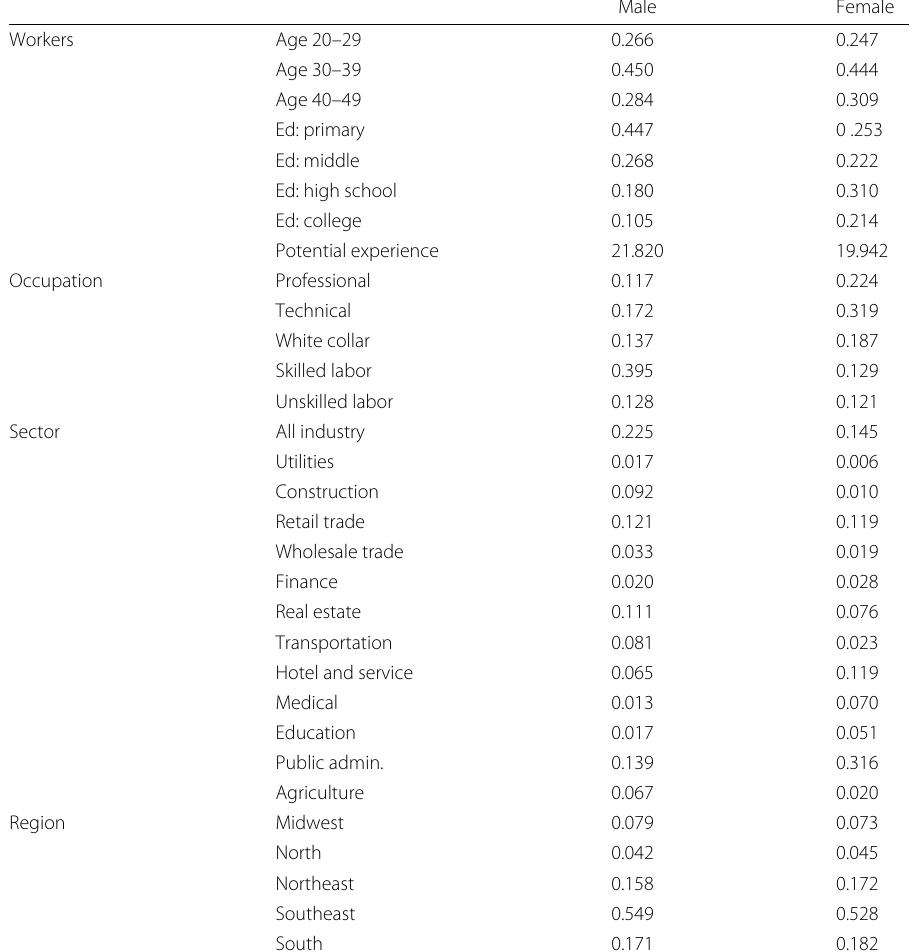
Table 8 Descriptive statistics of male and female formal-sector workers